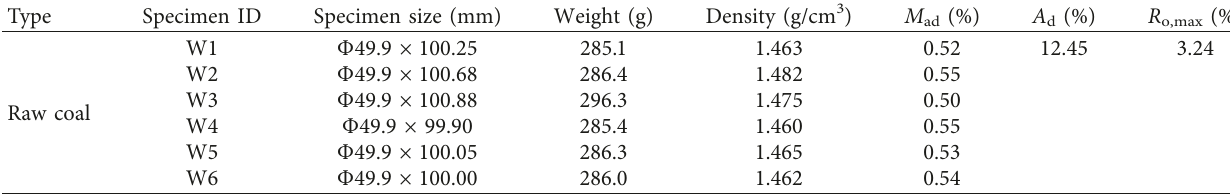
Figure 1: (a) Raw coal and (b) cylindrical coal specimen for Table 1: Features of experimental coal specimens.